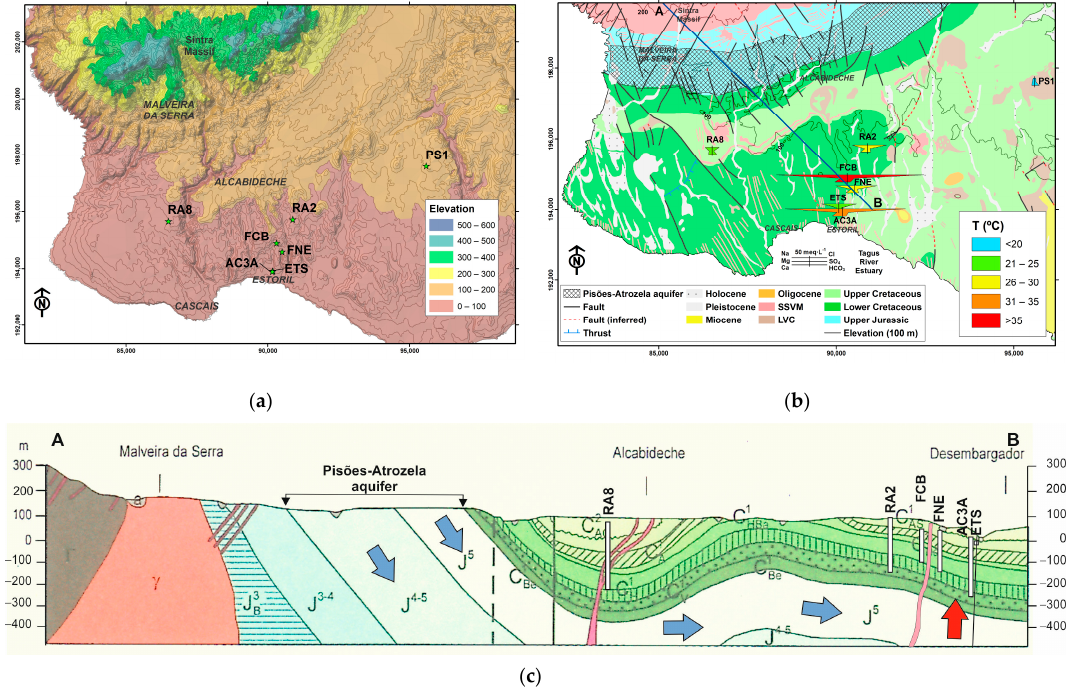
Figure 2. ( a ): Altitudinal map and ( b ) simplified geological map (right) of the study area, modified from [38], including sampling sites, water temperature and Stiff diagrams of water samples. ( c ): geological cross-section, modified from [38], including the sampling wells and the ETS spring loca- tions. Blue arrows: meteoric cold water downflow; red arrows: deep warm and saline inferred up- flow. Line of section A-B is shown in ( b ). Geological legend: J 3B , J 3 − 4 , J 4 − 5 and J 5 : limestones of Malm; C 1Be , C 1V , C 1H , C 1HBa , C 1Ba , C 1A and C 1AS : limestones, marls, and sandstones of Lower Cretaceous; C 2AC : limestones of Upper Cretaceous; Г and γ : Granites and Gabbros and sub-vertical intrusive dykes of Upper Cretaceous from Sintra Sub-Volcanic Massif (SSVM). 3. Sampling and Analytical Approach In order to achieve the main goals of this work, a total of seven water samples were collected for analyses in the study region between June 2013 and January 2014: six types of thermomineral water (five boreholes and one spring [ETS spring]) and one cold dilute water sample (PS1 well) assumed as representative of the regional groundwater [39,48]. The construction (depth and screen depth) and operating characteristics (flow) of the sam- pling points are shown in Table 1. The sample location and references are in Figures 1 and 2. AC3A well and ETS spring belong to Estoril Thermal Spa Center. A typical seawater composition from [49] has been also considered in this study. Water temperature, pH, electrical conductivity, total dissolved solids, and redox po- tential were measured at each sampling point using a Hanna multiparameter portable probe, model HI-9828 (accuracies ±0.15 °C, ±0.02 pH units, ±1 µS/cm at 25 °C, ±1 mg/L, and ±1.0 mV, respectively). Water samples for laboratory analyses were also collected and stored at each sampling point in order to determine major elements (SiO 2 , Ca 2+ , Mg 2+ , K + , Na + , HCO 3 − , Cl − , SO 42 − , NO 3 − , Br − ) as well as different isotopic content ( δ 18 O H2O , δ 2 H H2O , δ 13 C TDIC , 3 H, 14 C, δ 34 S SO4 , δ 18 O SO4 ).